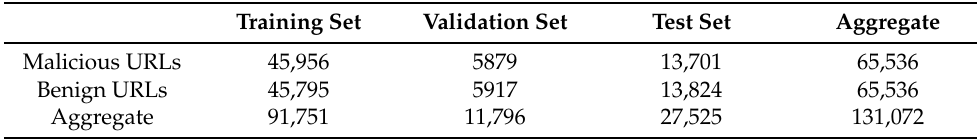
Table 2. Number of samples in each data